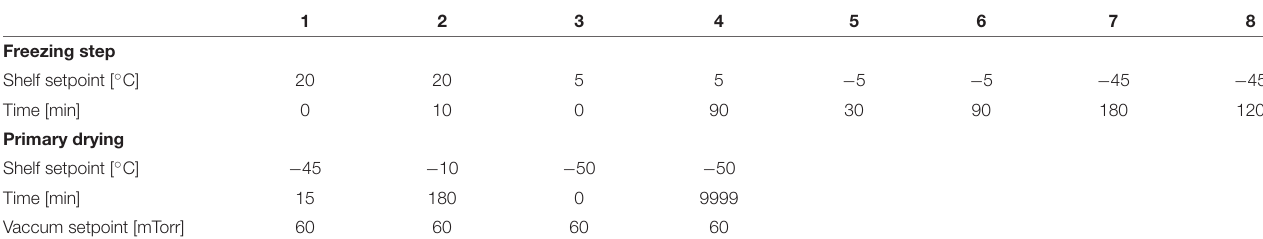
TABLE 5 | Freeze drying recipe used for pure water.